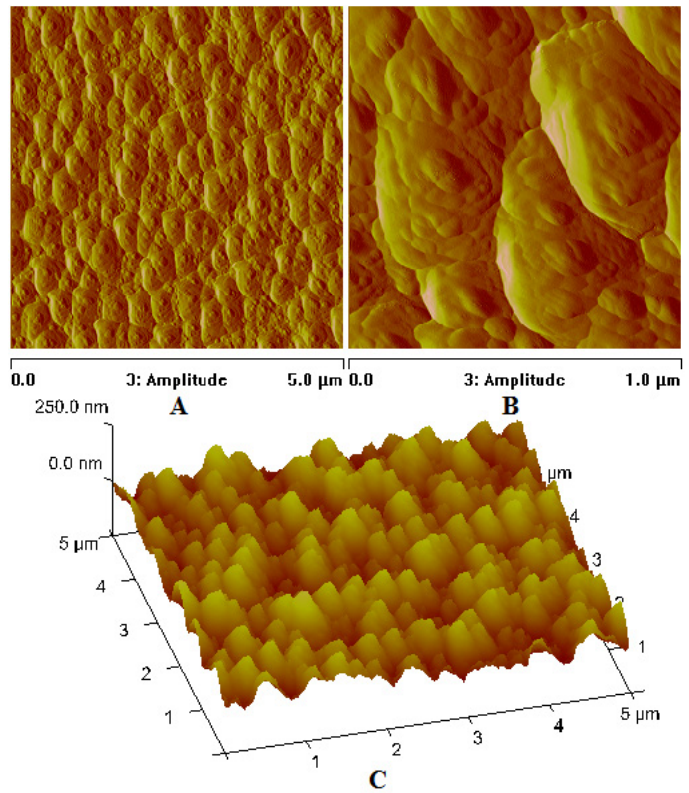
Figure 21. AFM images of [Cu 2 (EtNH 2 ) 2 (µ-O 2 CC 3 F 7 ) 4 ] ( 3 )/Si immersion time 20 s, Mag 5 µm ( A ); Mag 1 µm ( B ) height ( C ), after heating. Additionally, for [Cu 2 (EtNH 2 ) 2 ( µ -O 2 CC 3 F 7 ) 4 ] ( 3 )/Si covers after heating, TEM anal-